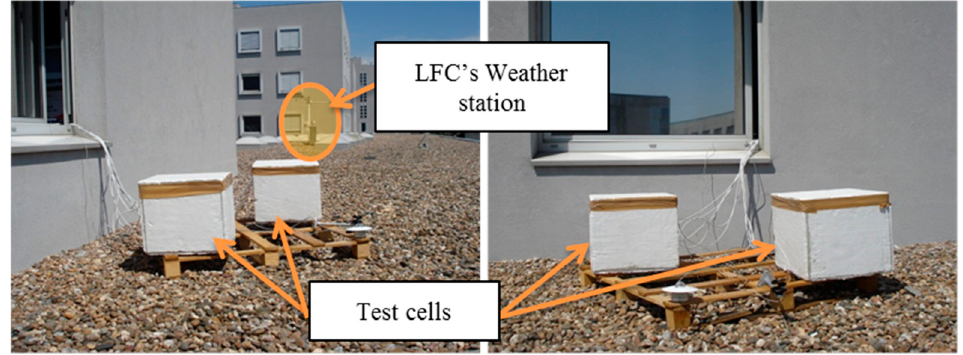
Figure 3. In situ monitoring of test cells—roof of the 1st floor of the building G, FEUP, Porto.